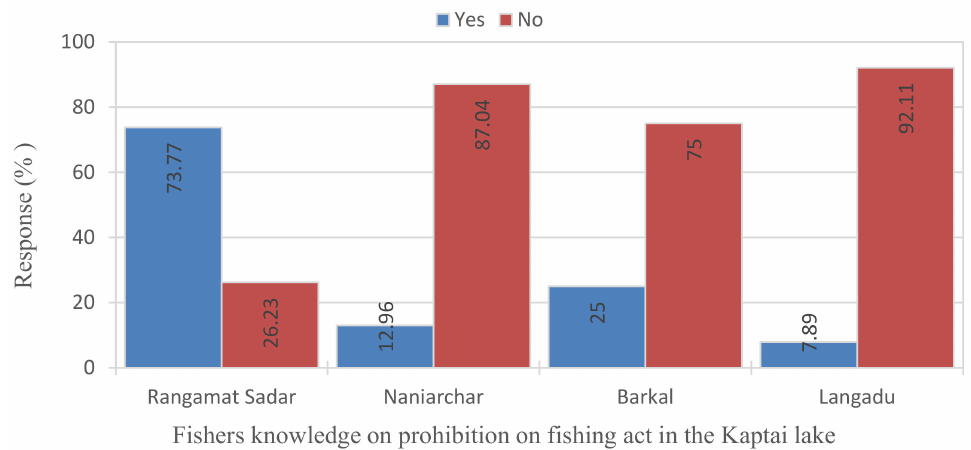
Figure 9. Fishermen’s knowledge about fishing laws and prohibition of the fishing activities in the study